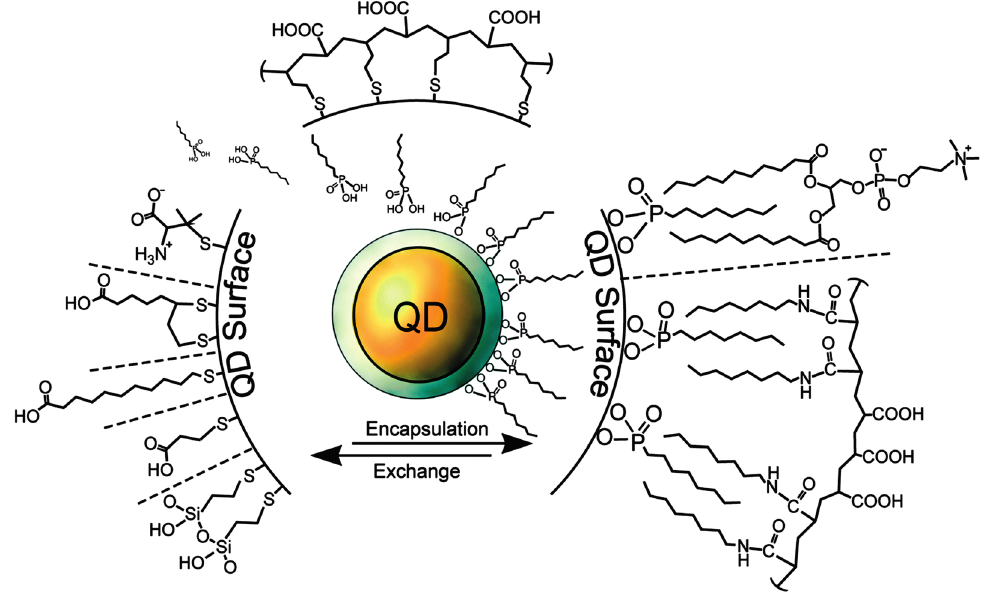
Figure 2. Selected surface chemistries and conjugation strategies, as they apply to QDs. The core/shell NC is depicted in yellow/grey. After synthesis, trioctylphosphene (TOP) surrounds the QD surface (represented by the ligands directly on the grey shell